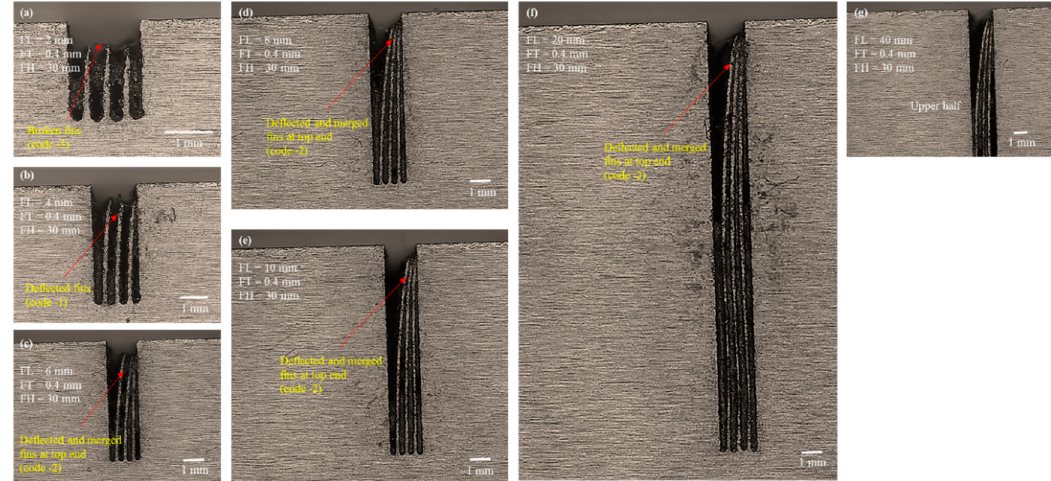
Figure 10. Microscopic analysis of structure traits under the second phase of experimentation with designed fin thickness (FT_d) of 0.4 mm and FH 30 mm: ( a ) FL 2 mm, ( b ) FL 4 mm, ( c ) FL 6 mm, ( d ) FL 8 mm, ( e ) FL 10 mm, ( f ) FL 20 mm, and ( g ) FL 40 mm upper half.